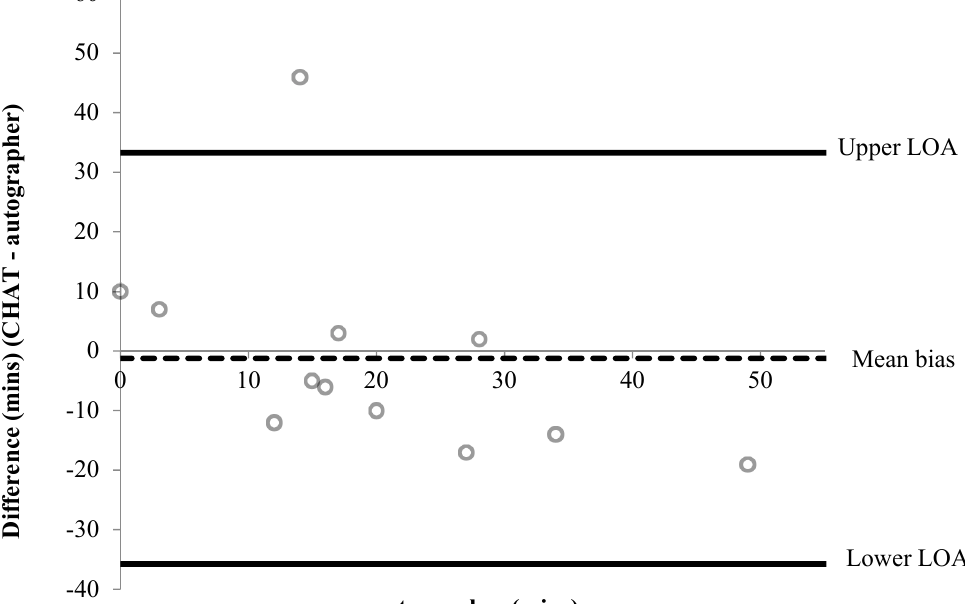
Figure 2. A Bland–Altman plot demonstrating the difference between self-reported and autographer- derived sleep time ( n = 6). A mean bias of +27 min (±21 min) with LOA of + 68 and − 13 min is shown.